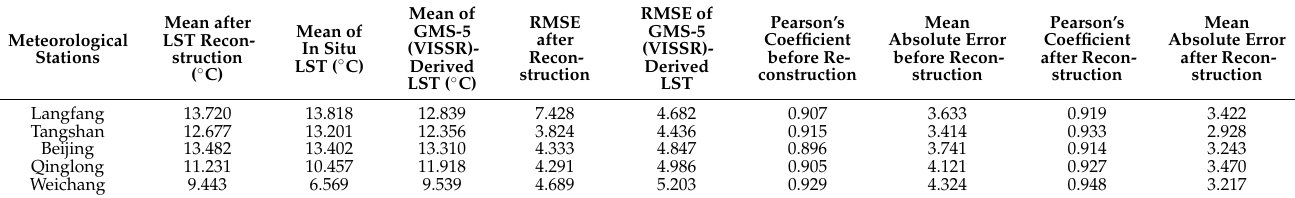
Table 4. The mean and RMSE of the derived, the in situ, and the reconstructed surface